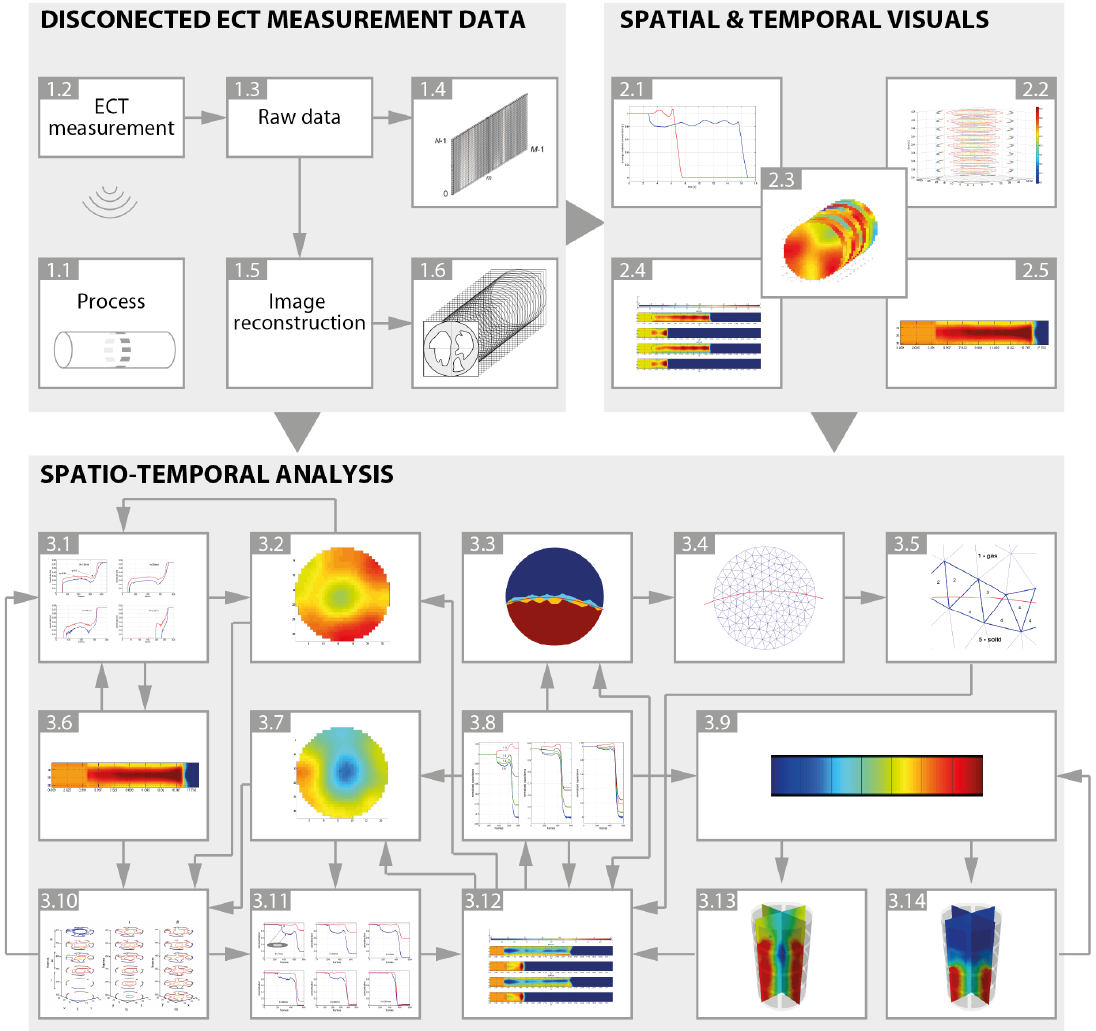
Figure 3. Three levels of measurement data analysis. Block #1 ( upper left corner ) illustrates the capture and preparation of measurement records in the form of raw data vectors and initially reconstructed image streams. Block #2 ( upper right corner ) represents carefully generated visuals of temporal sequences of values and 2D images. Block #3 ( bottom block ) represents a variety of workflow traces among the different possible graphs, 2D reconstructed images, simulations, topograms and 3D visualizations. The arrows indicate the order in which the visuals are normally analyzed by the experts/during the process